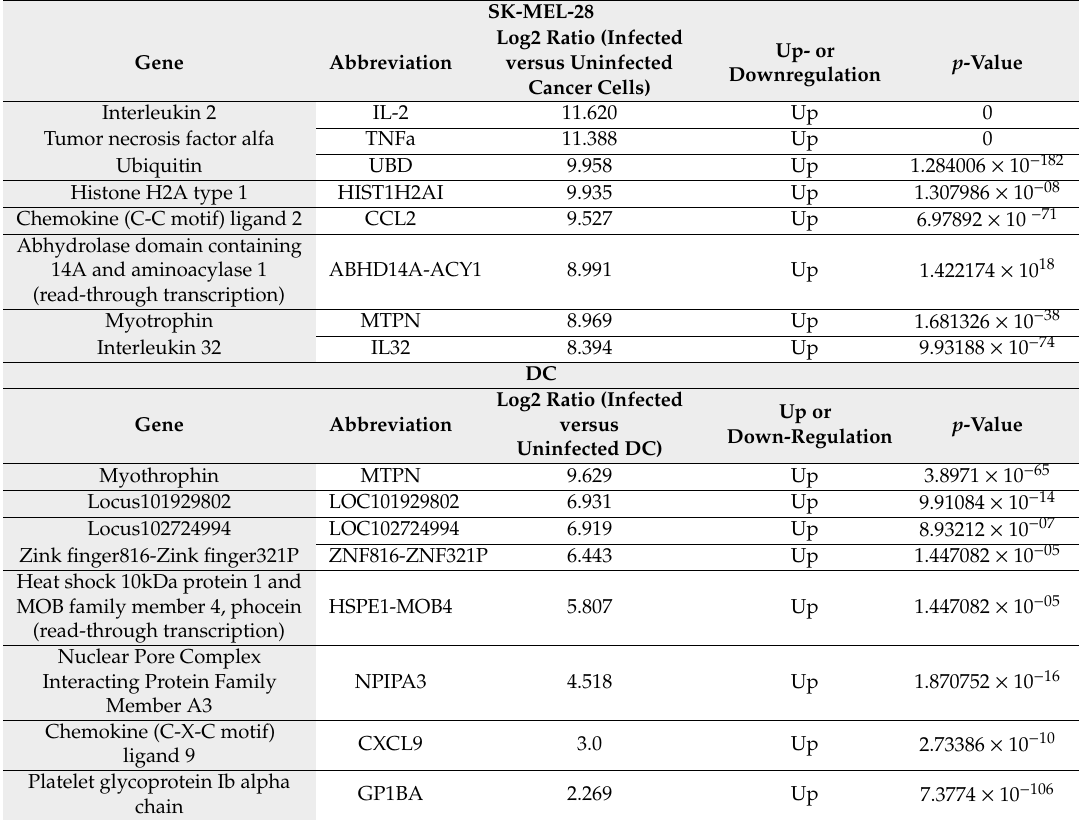
Table 1. In vitro assessment of intracellular virus-induced signaling in OAd.TNFa-IL2-infected SK-MEL-28 melanoma cells or dendritic cells (DCs), evaluated by RNA-sequencing: Top 8 genes showing the most marked upregulation in RNA expression levels as measured through RNA-sequencing (Poisson distribution filtering applied) are listed. Note that the virus codes for TNFa and IL-2 but transgene expression is linked to replication, which only occurs in tumor